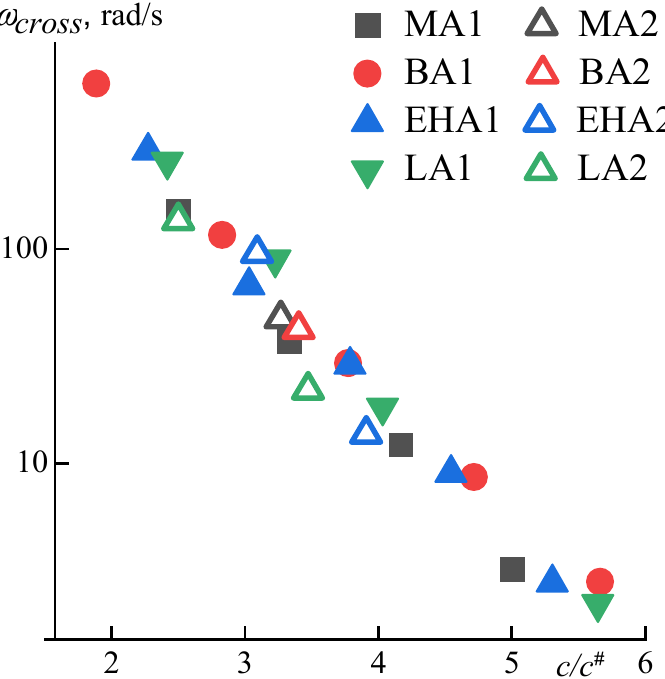
Figure 6. Dependence of the crossover frequency of terpolymers on the c / c # parameter, which characterizes the entanglements’ density.